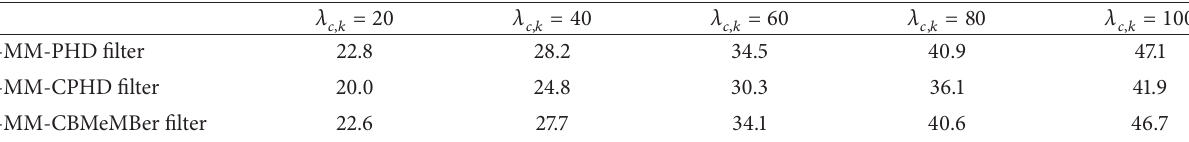
Table 3: Time-averaged OSPA distance ( 𝑚 ) in various 𝜆 𝑐,𝑘 .